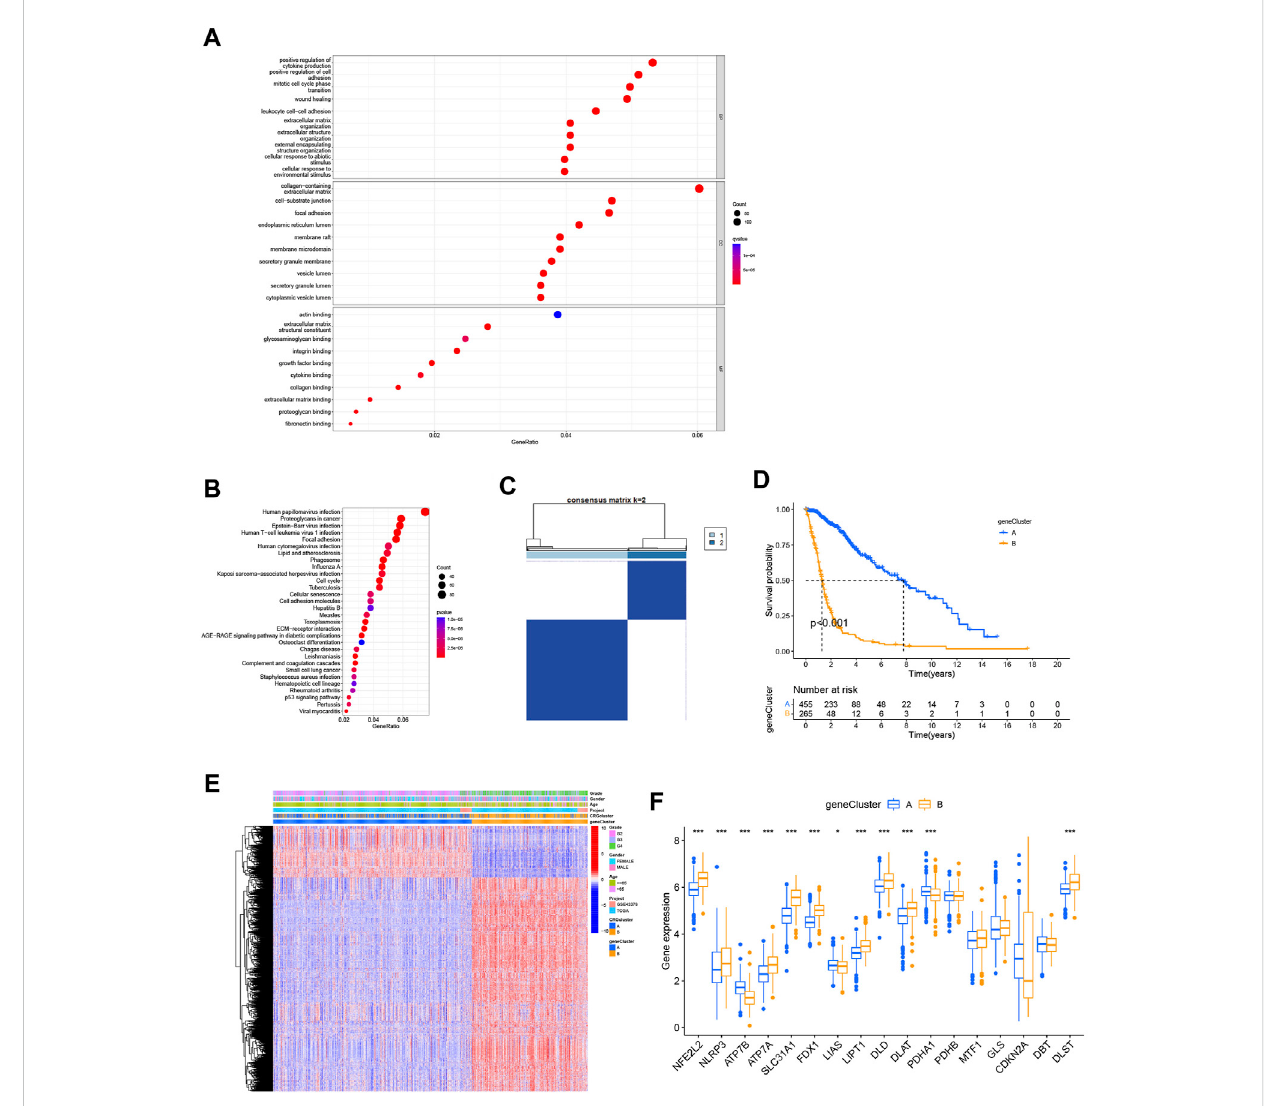
FIGURE 4 Identi fi cation of the gene subtypes. (A,B) KEGG and GO enrichment analysis of cuproptosis subtype related genes. (C) Consensus clustering algorithmheatmapwithk=2decidedon2genesubtypes. (D) Kaplan-Meieranalysisof2genesubtypes. (E) Heatmapofgenesubtypes. (F) Differencesof cuproptosis-related genes expression between 2 gene subtypes. (* p < 0.05; ** p < 0.01; *** p <